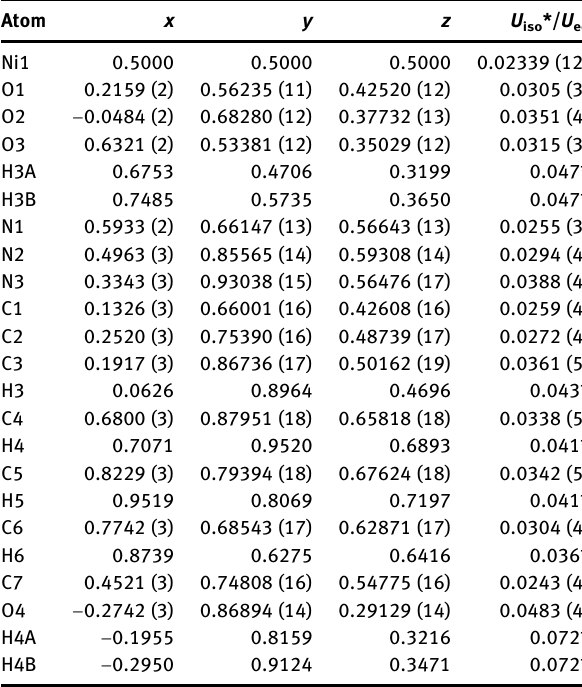
Table  : Fractional atomic coordinates and isotropic or equivalent isotropic displacement parameters (Å 